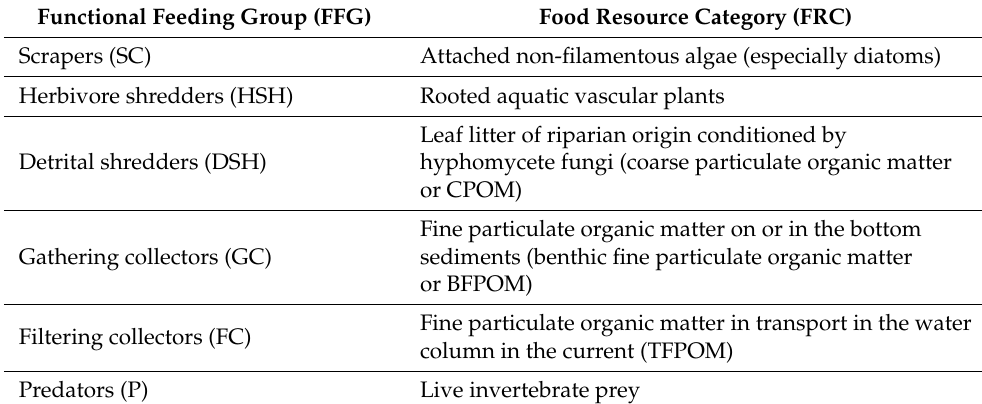
Table 1. Stream macroinvertebrate functional feeding groups (FFGs) and the corresponding food resource categories upon which they